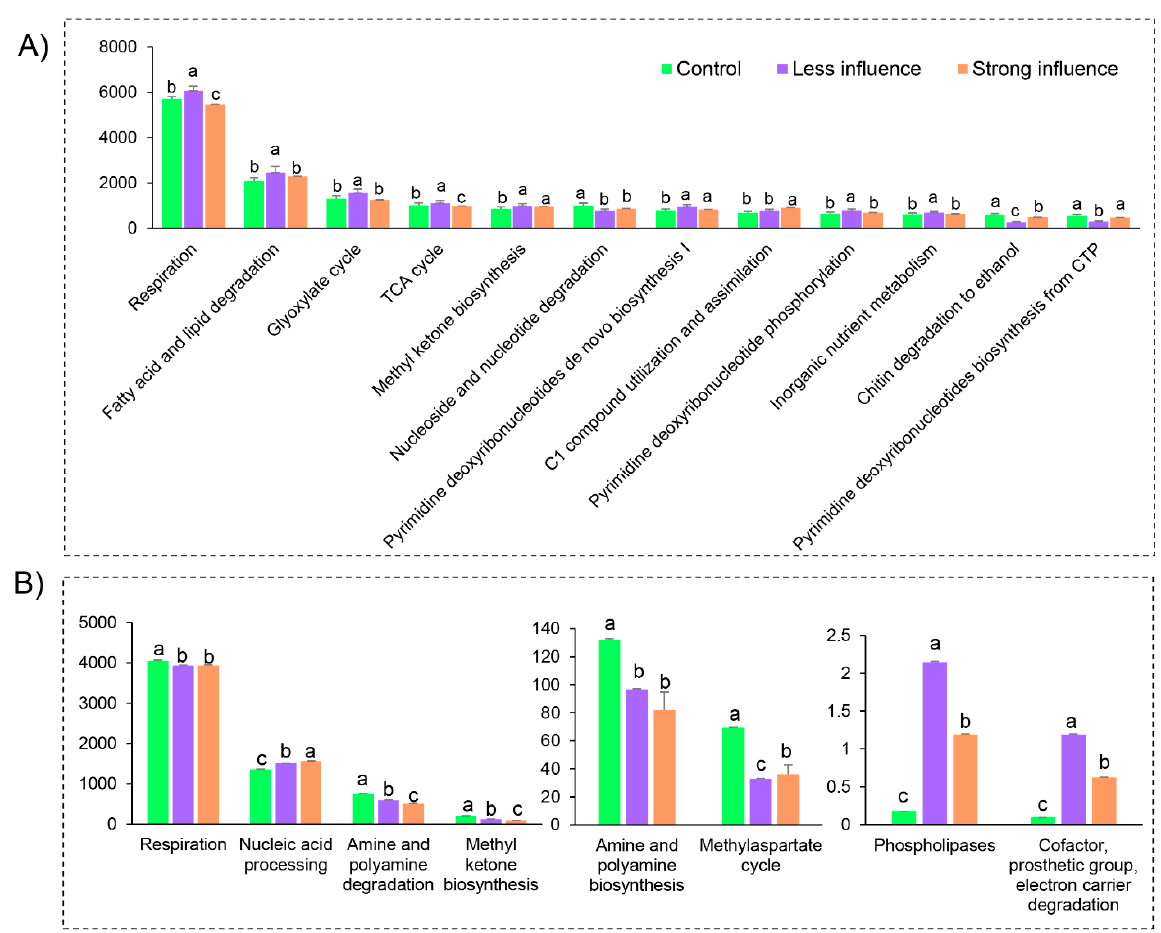
Figure 7. Microbial community functional abundance prediction based on MetaCyc genome database. Bacterial ( A ) and fungal ( B ) functional profiles in Stropharia rugosoannulata cultivation areas with different influencing intensities are shown as bar charts. Values are the mean from four bioreplicates, different lowercase letters indicate significant differences at p < 0.05 (ANOVA, Tukey HSD).